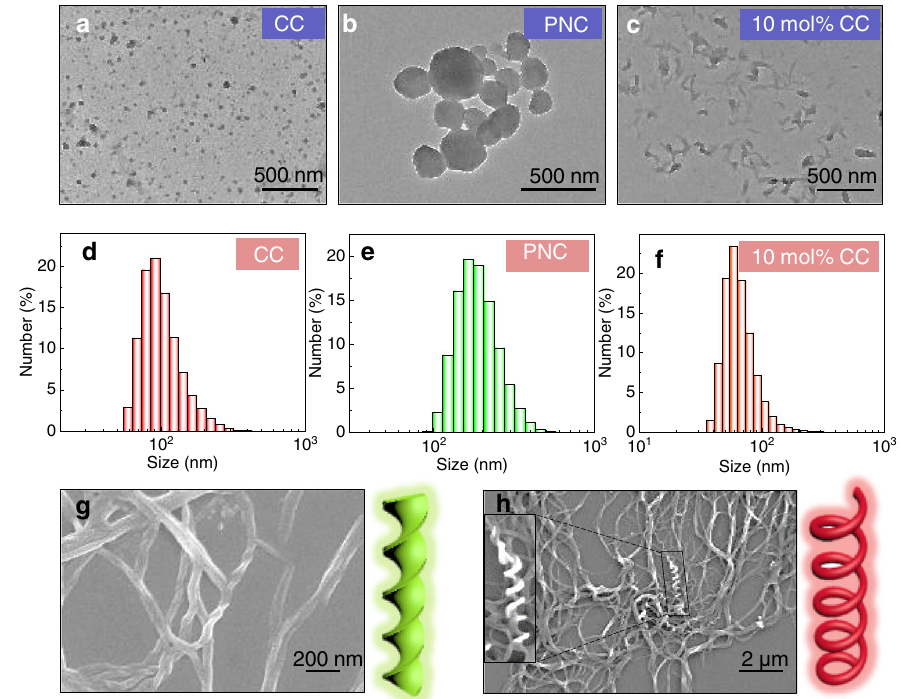
Fig. 2 Self-assembly and coassembly of PNC and CC. TEM images of a CC (10 − 4 M, THF/H 2 O = 1/9 v/v), b PNC (10 − 4 M, THF/H 2 O = 1/9), c PNC/CC ([PNC] = 10 − 4 M, [CC] = 10 − 5 M, THF/H 2 O = 1/9). DLS size distribution of d CC (10 − 4 M, THF/H 2 O = 1/9), e PNC (10 − 4 M, THF/H 2 O = 1/9), f PNC/ CC ([PNC] = 10 − 4 M, [CC] = 10 − 5 M, THF/H 2 O = 1/9). SEM images of g PNC (10 − 4 M, THF/H 2 O = 3/7), h PNC/CC ([PNC] = 10 − 4 M, [CC] = 10 − 5 M, THF/H 2 O = 3/7). Green twist and red helix are cartoons to show the features of corresponding morphologies of PNC and PNC/CC